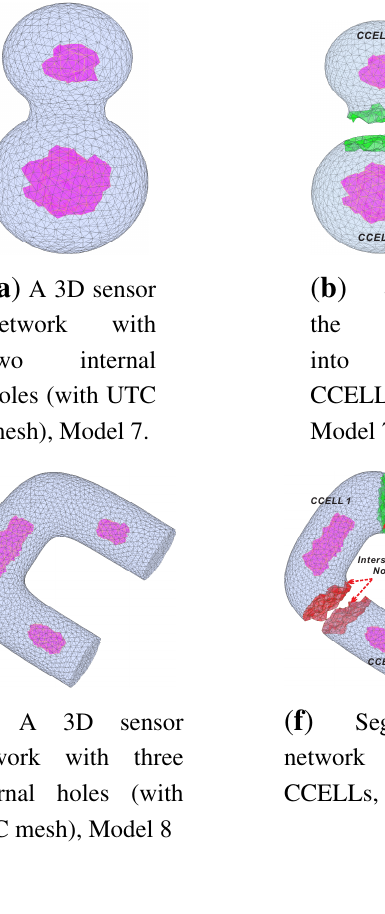
Figure 8. Illustration of the proposed greedy routing protocol for a network with multiple internal holes, Models 7 and 8 used in our simulations. ( a , e ) 3D sensor networks that have irregular outer and inner boundaries and have multiple internal holes. The nodes on the inner boundary are highlighted in purple. ( b , f ) After the segmentation, the networks are decomposed into cluster cells (CCELLs), each containing one hole only. The intersection nodes are highlighted in green and red. Additionally, we separate the CCELLs further apart for a clearer view. ( c , g ) The result after volumetric harmonic mapping, with both outer and inner boundaries mapped to spheres for each CCELL. The intersection nodes are in green and red, and here, we partially “align” the CCELLs to get a better view, but actually, the virtual coordinates of these CCELLs are independent of each other. ( d , h ) An example of the greedy routing path according to our proposed scheme is shown in the original network